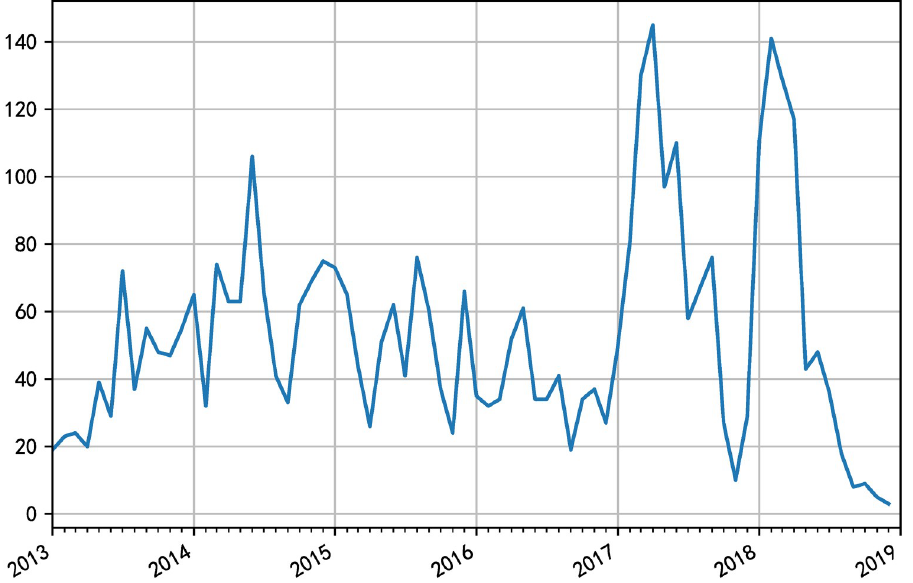
Fig 8. Exploit disclosures added to the Exploit Database (EDB) by